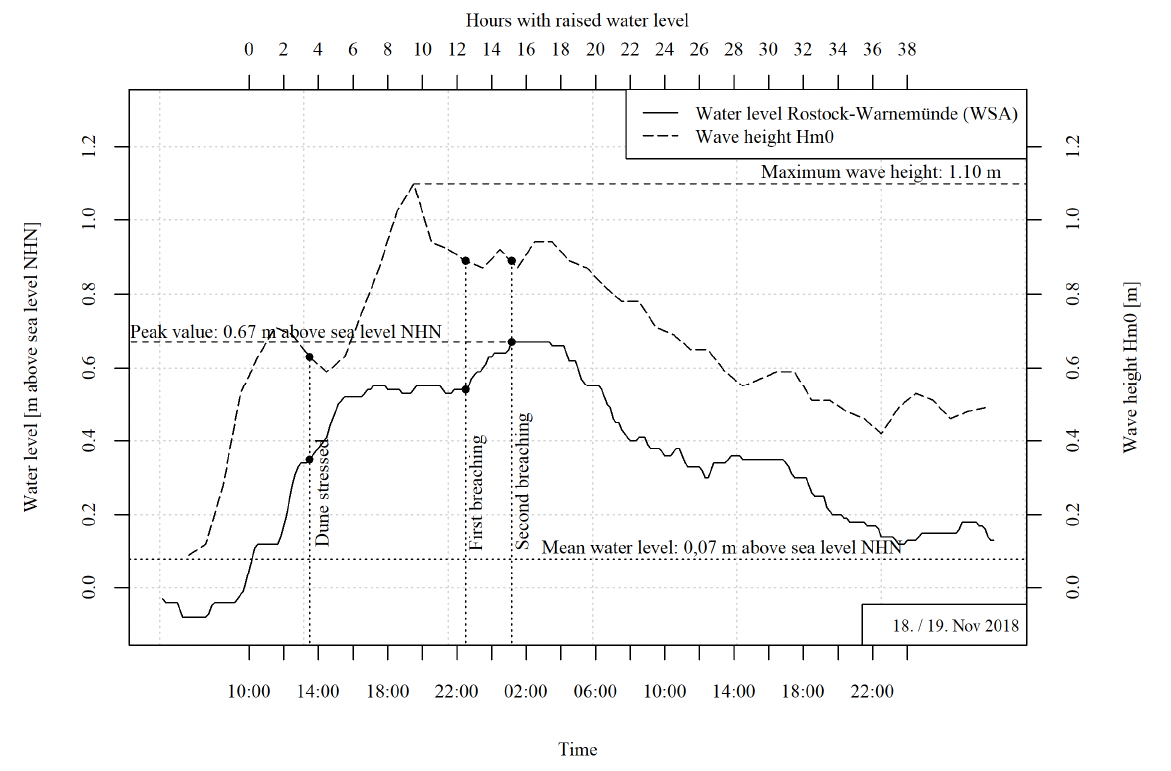
Figure 10. Water level and wave height of the storm surge. Wave height in 10 m depth (buoy approximately 1700 m distance from shore) [35].